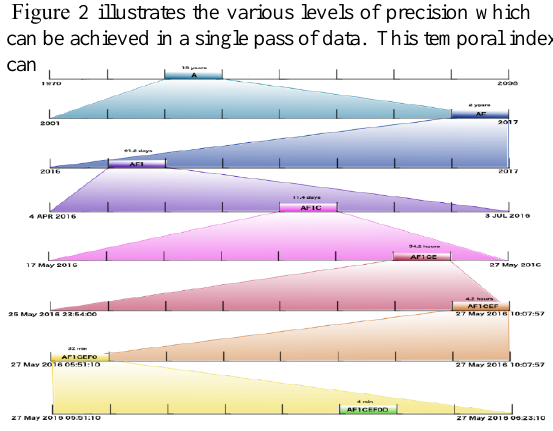
Figure 2. Time hashes with eight levels of precision